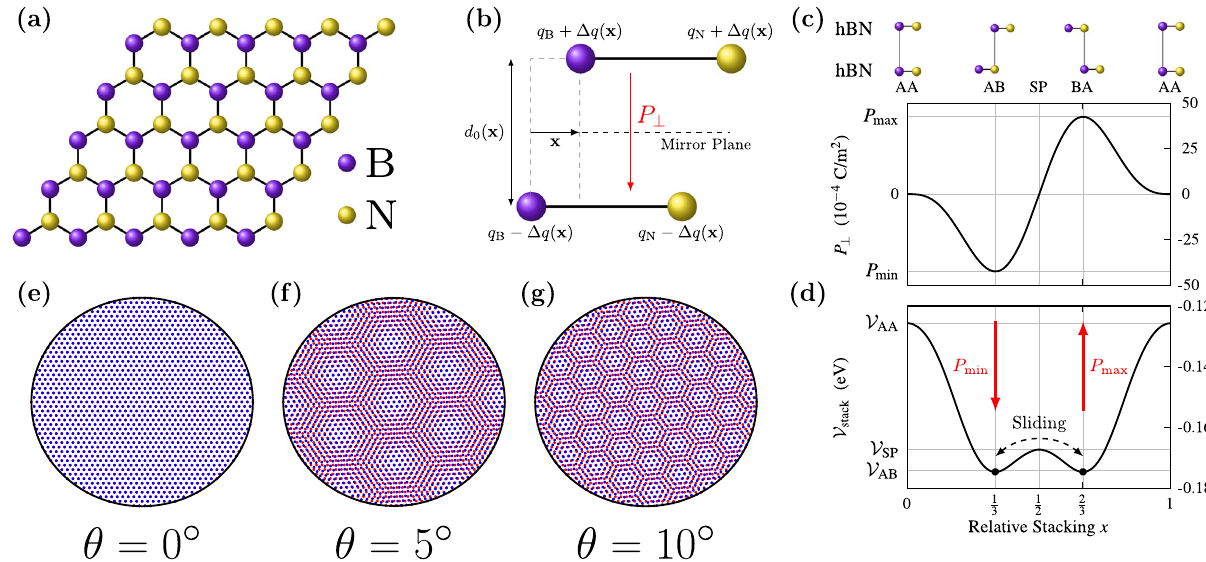
Fig. 1 | Ferroelectricity in twisted bilayers. a Sketch of a monolayer of hBN. b Illustration of the interlayer charge transfer Δ q ( x ) and resulting polarization arisingfromrelativesliding x inbilayerhBN,where q B and q N arethechargesofthe BandNatoms,respectively,and d 0 ( x )istheequilibriumlayerseparation. c Out-of- plane polarization P ⊥ and d stacking energy V stack in bilayer hBN as a function of relative stacking x along the unit cell diagonal, from fi rst-principles calculations in